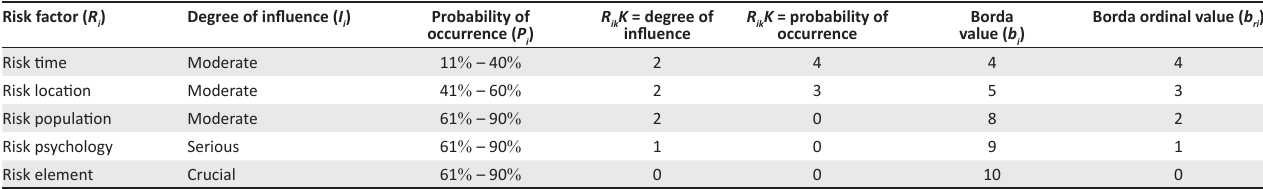
TABLE 6: Ranking of the importance of each risk factor in the ‘Shanghai slashing of primary school students’ incident (Borda value). Risk factor ( R i